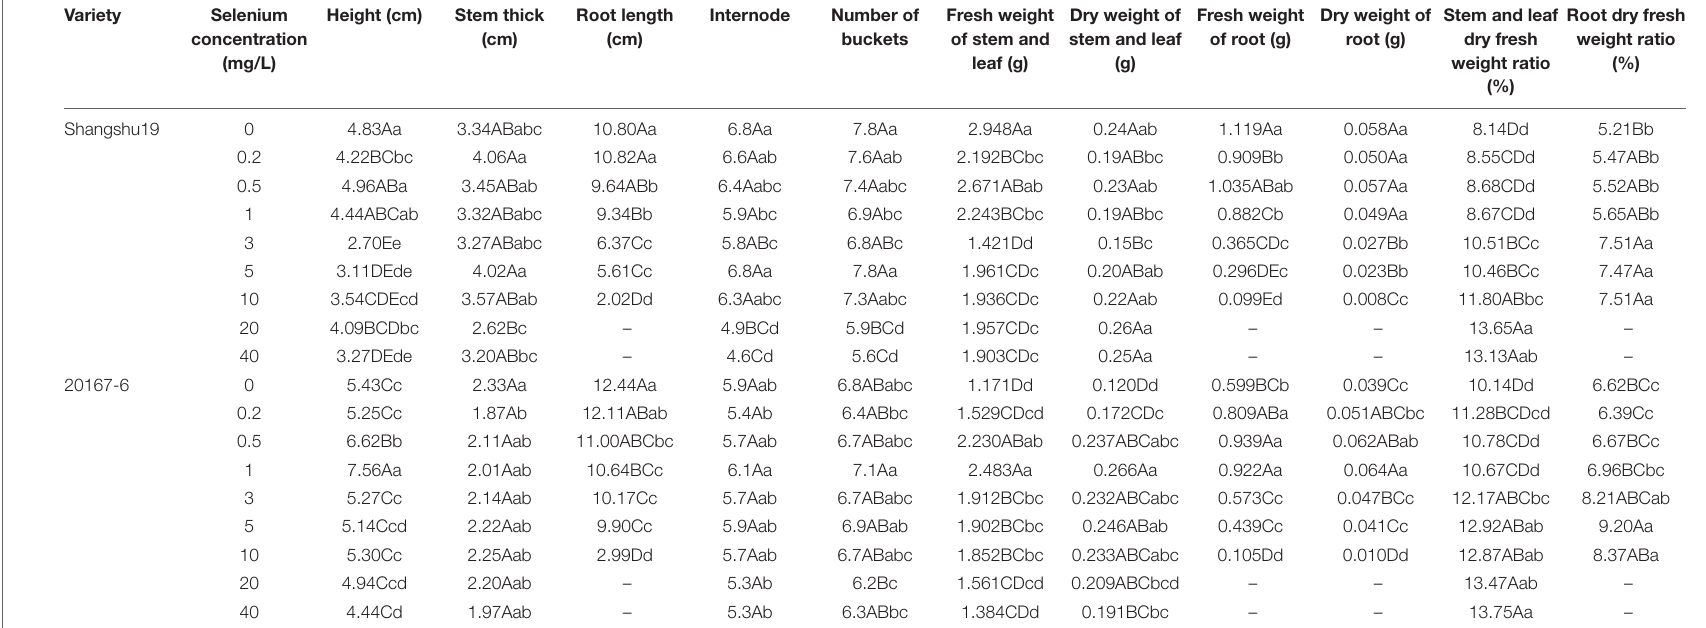
TABLE 5 | Effects of different selenium concentrations on the growth of sweet potato seedlings in water culture.